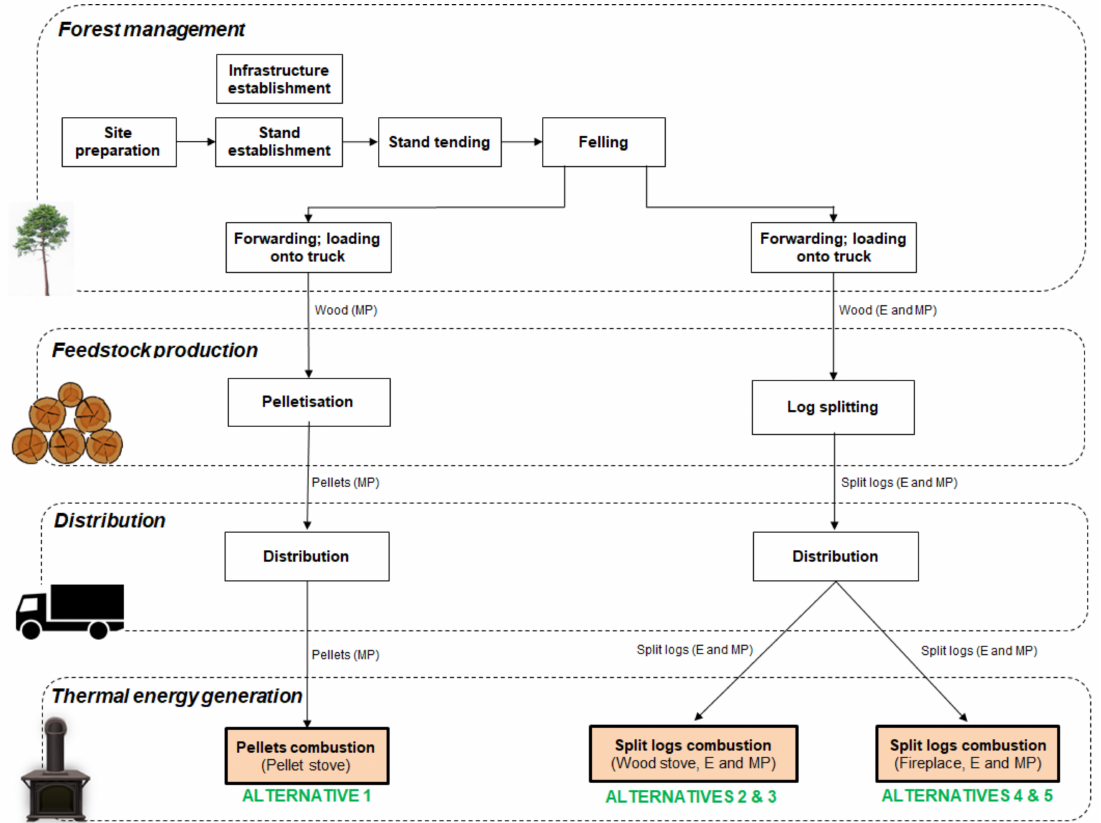
Figure 1. Simplified diagram of the wood-based residential heating alternatives in the MCDA prioritisation (E = eucalypt; MP = maritime